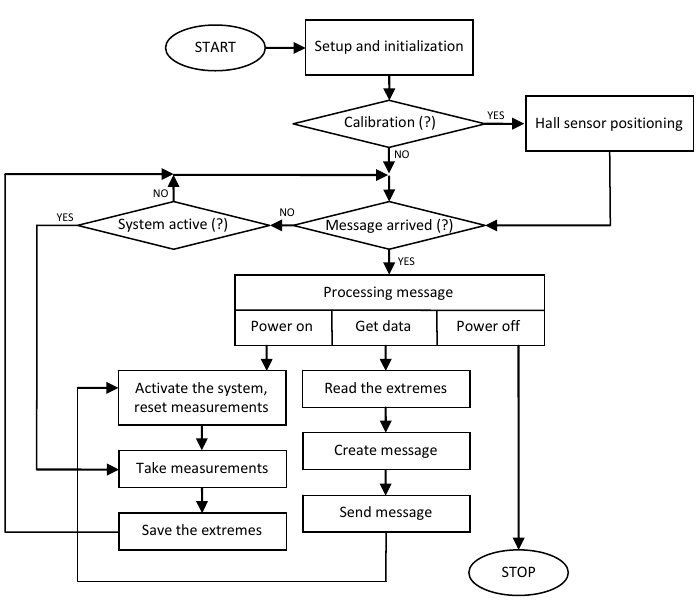
Figure 8. Algorithm of the program running on the sensor node.